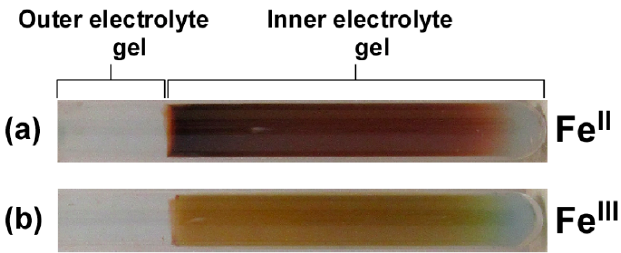
Figure 2. Well-developed precipitation patterns of Cu-Fe PBA formed at 25 °C in the conventional RD setup (schematically shown in Figure 1a) under the following initial conditions. Outer electrolyte gel: [Cu 2+ ] = 0.250 M and 1.0 mass% agarose. Inner electrolyte gel: ( a ) [[Fe(CN) 6 ] 4 − ] = 0.025 M and ( b ) [[Fe(CN) 6 ] 3 − ] = 0.025 M, both with 1.5 mass% agarose. The elapsed time after the addition of the outer electrolyte sol was 135 h.